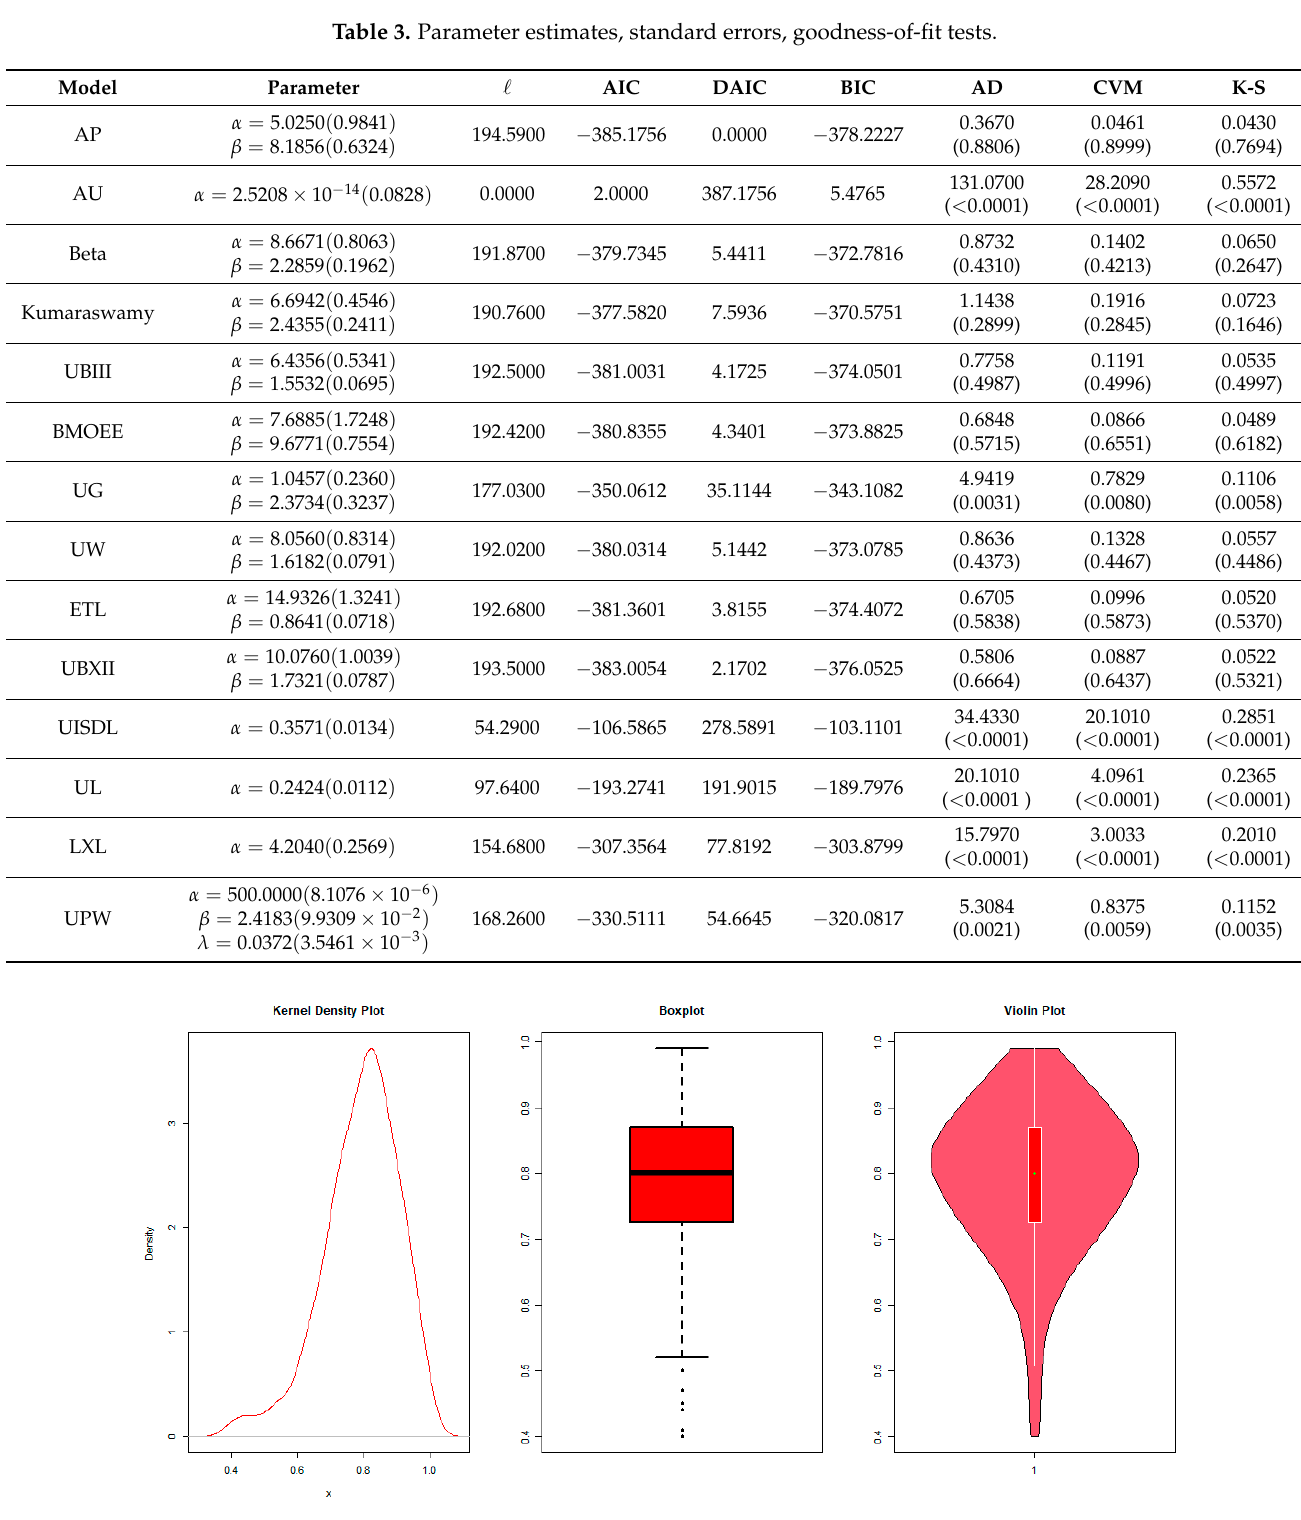
Figure 7. Kernel density, boxplot, and violin plots.